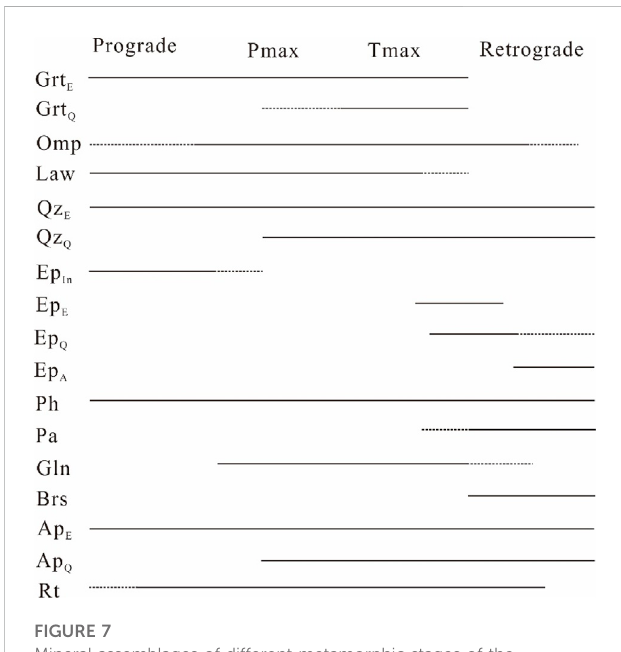
FIGURE 7 Mineral assemblages of different metamorphic stages of the sample